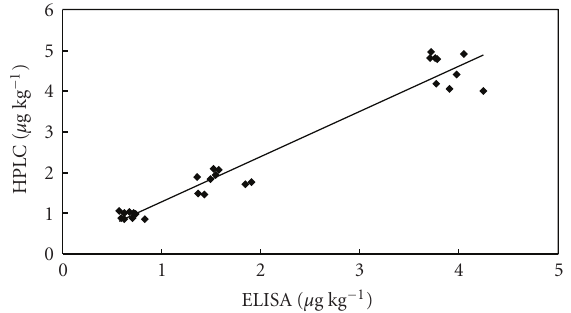
Figure 7: Correlation between ELISA and HPLC results for non- purified pig liver spiked with ractopamine at three levels ( y = 1 . 1125x + 0 . 1669, R 2 = 0 . 9517, n =